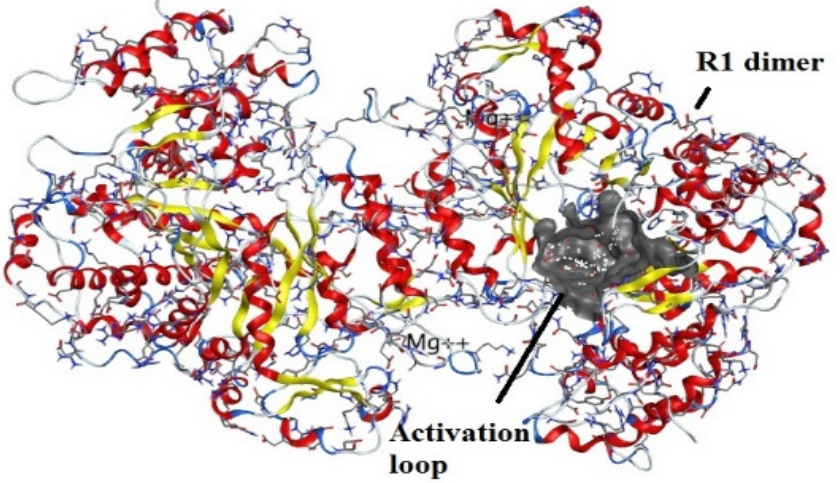
Figure 10. Crystallographic structure of ribonucleotide reductase, black clouds indicating activation loop .